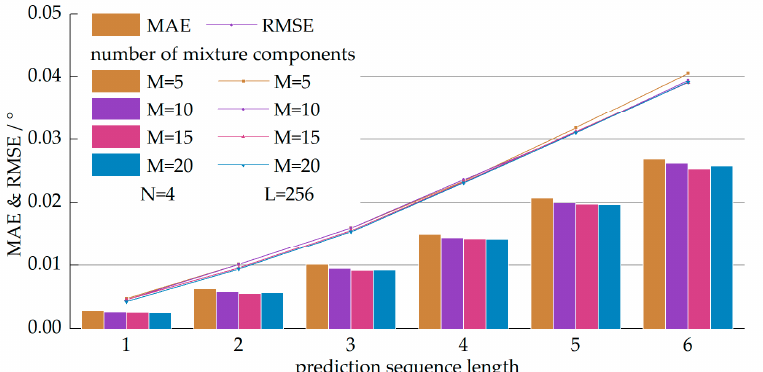
Figure 8. Performance of models with a different number of mixture components where N = 4, L = 256. The horizontal axis denotes the prediction sequence length. The vertical axis denotes the value of the MAE and RMSE. The bars represent the value of the MAE and the solid lines represent the value of the RMSE. The optimal parameter configuration of the BiRMDN is set out in Table 1.